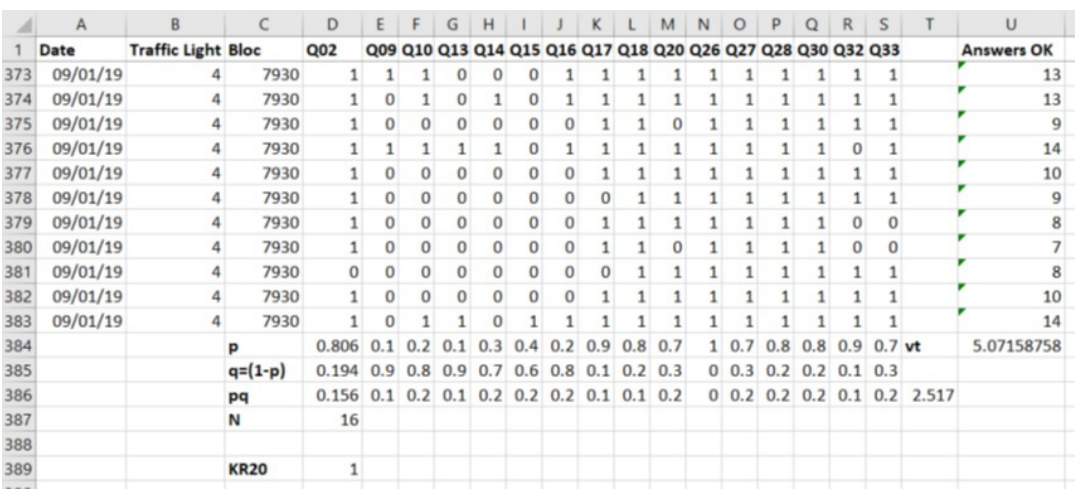
Table 6. Result frequencies. From question 1 to